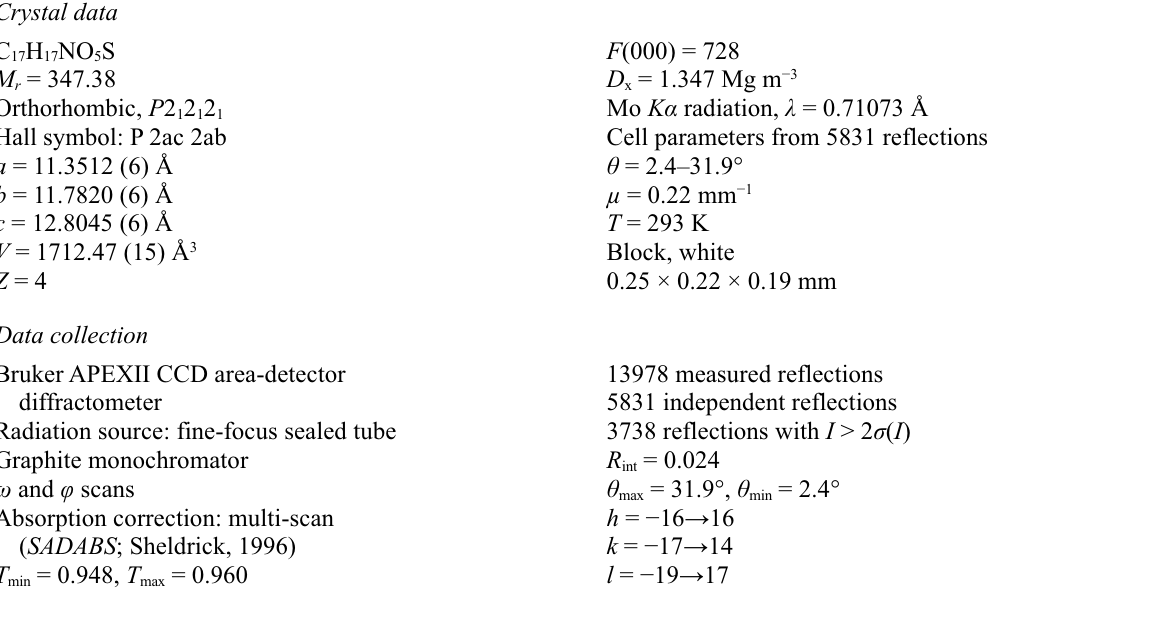
Molecular packing in the title compound, viewed down the b axis. Dashed lines represent hydrogen bonds. Ethyl 2-[ N